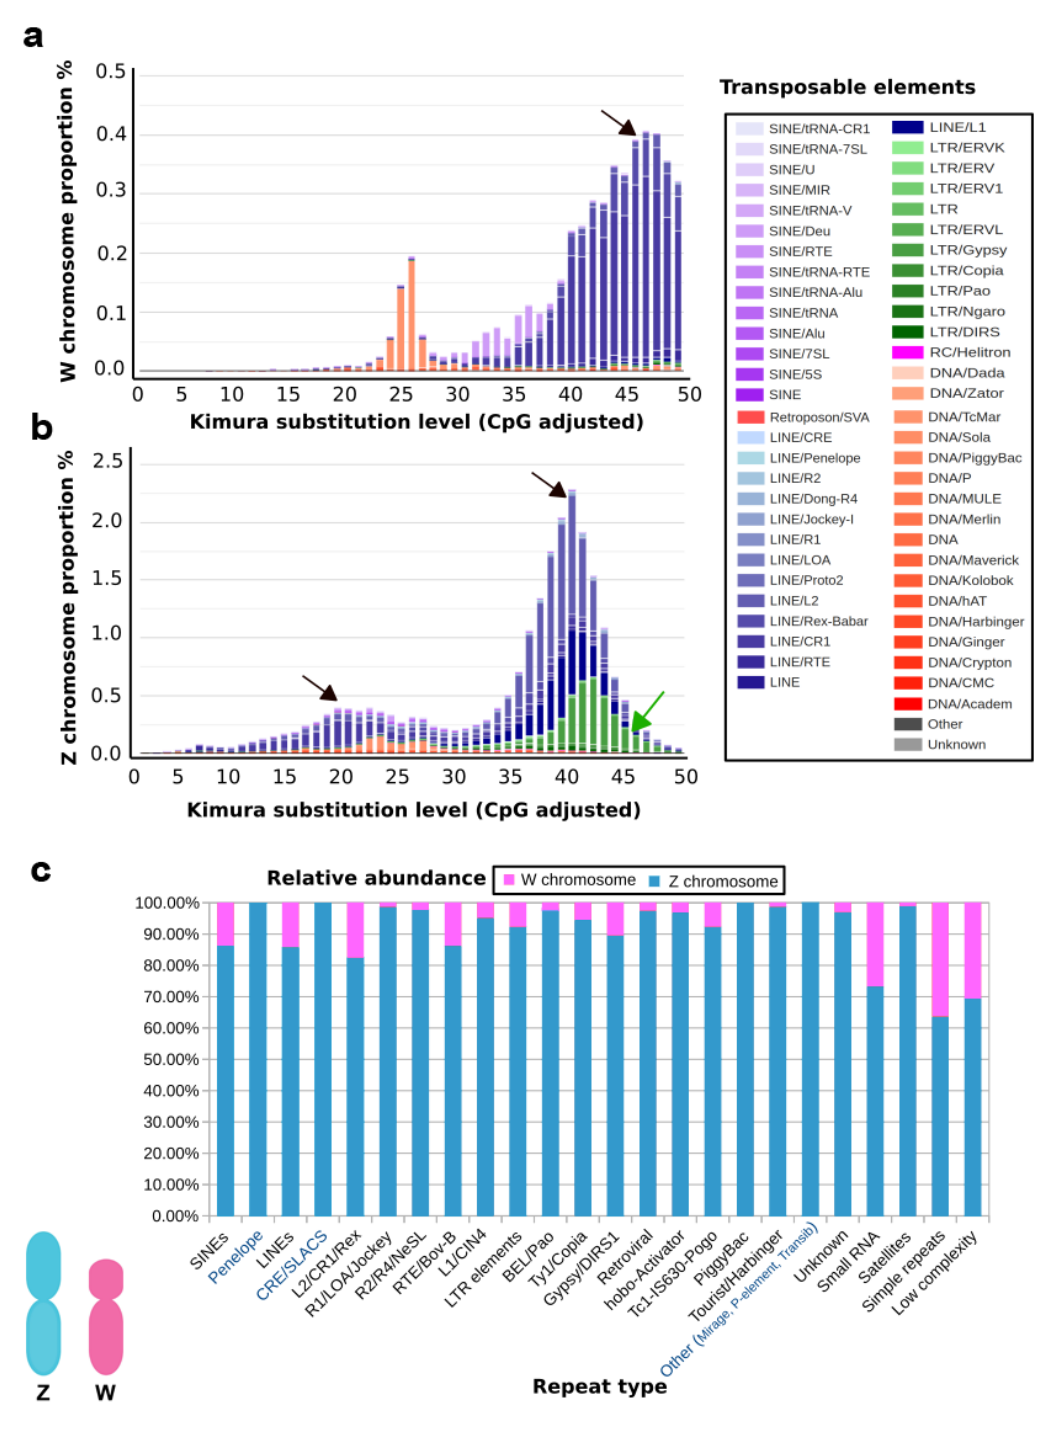
Figure 3. Comparative genomic characterization of repeated DNA contents between the W and Z sex chromosomes. Repeat landscape of ( a ) W and ( b ) Z sex chromosomes. Histogram plots show the degree of sequence divergence of each transposable element (TE) derived from its consensus ( X -axis) in relation to the percentage of its copies in the total genetic contents of the chromosome ( Y -axis). Peaks represent waves of insertion (black arrows) of elements into the sex chromosome. Older insertions of TEs are shown as a peak wave on the right side ( K -value > 25) of the plot, whereas younger elements are depicted on the left side ( K -value < 25). Different colors show distinct element types, as described on the right. A higher abundance of LTRs (green) of the Z sex chromosome landscape as indicated by